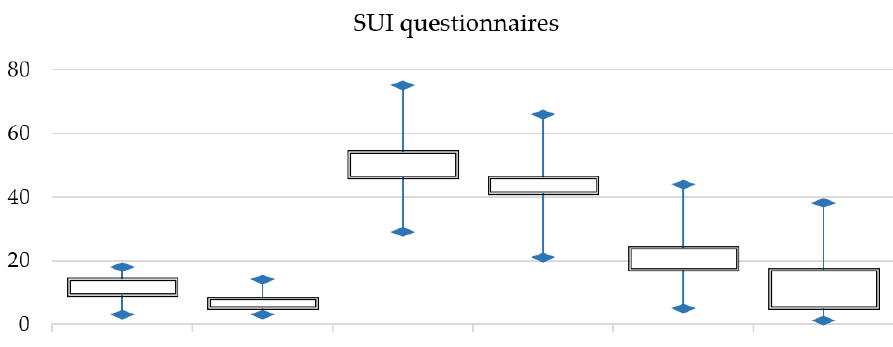
Figure 1. SUI changes in patients reported outcomes.